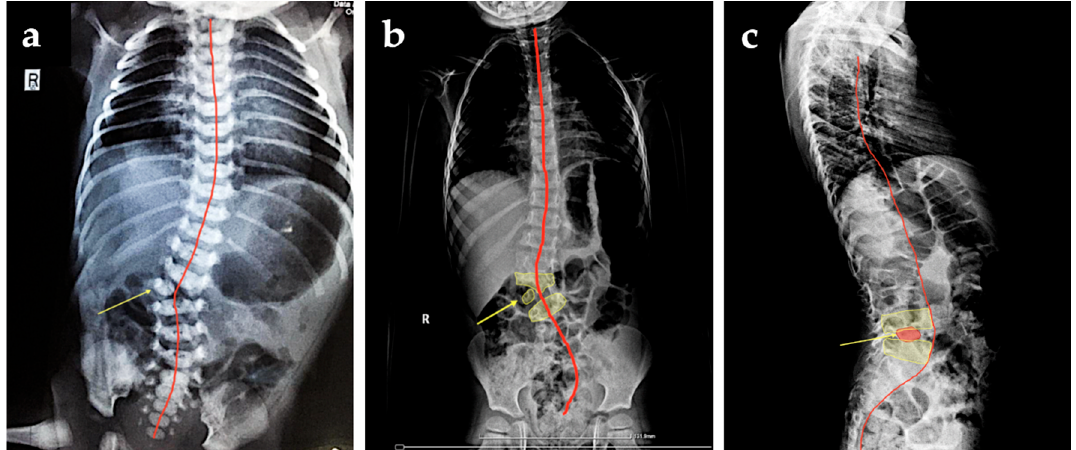
Figure 3. X-ray findings: ( a ) anteroposterior face of the child’s spine at 8 months after delivery indicating hemivertebra (yellow arrow); ( b ) anteroposterior X-ray face of the patient spine at 4-years- old depicting hemivertebra (yellow arrow) and scoliosis (red line), ( c ) lateral profile of the spine focused on the thoracolumbar section revealed the hemivertebra (yellow arrow), and curvature of the spine (red